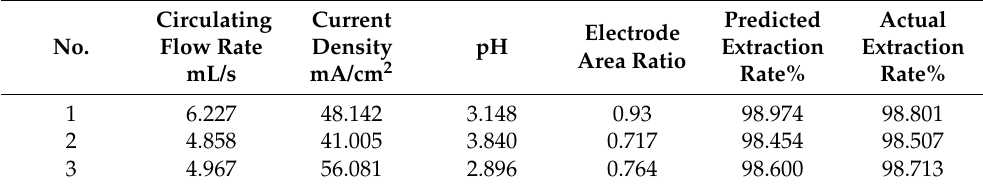
Table 7. The recommended scheme and its prediction results and the experimental results.